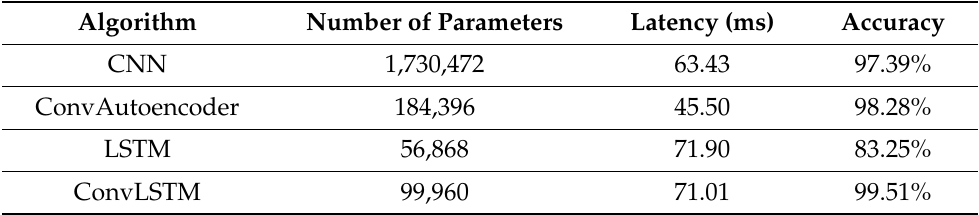
Table 2. Comparison of the studied classification algorithms for the gesture